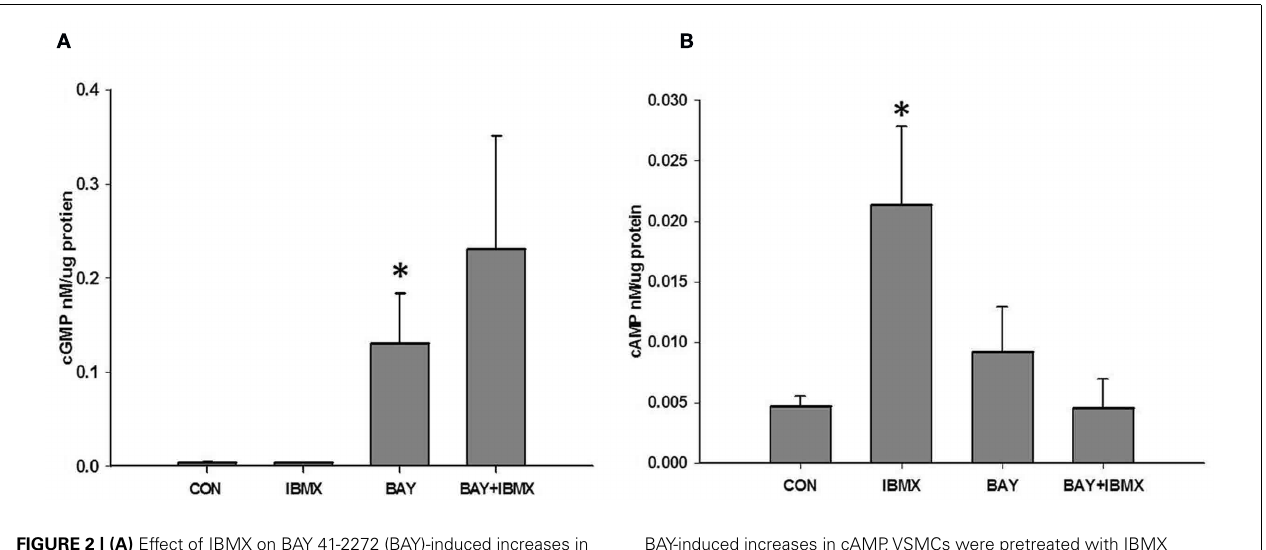
FIGURE 2 | (A) Effect of IBMX on BAY 41-2272 (BAY)-induced increases in cGMP.VSMCs were pretreated with IBMX (10 μ M) or vehicle for 30min prior to stimulation with BAY (10 μ M) for 60min ( n = 15).Values are the means ± SE. *Different from control ( P < 0.05). (B) Effect of IBMX on